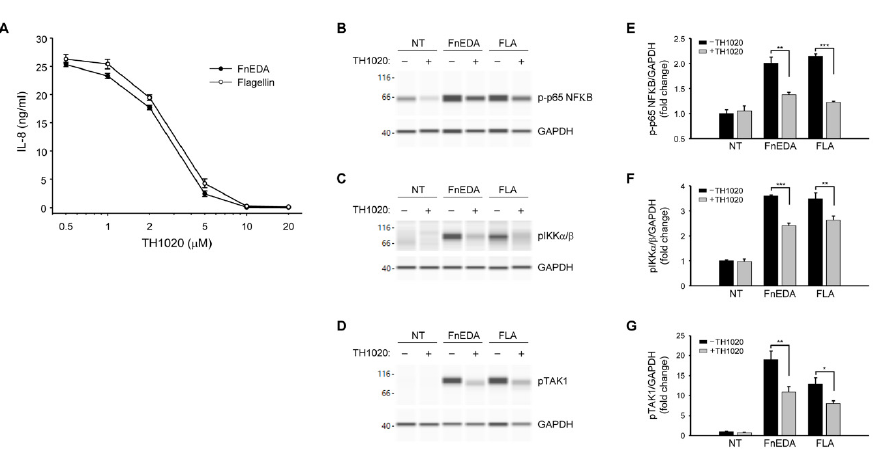
Figure 4. The TLR5 inhibitor, TH1020, blocks FnEDA-dependent IL-8 synthesis and NF κ B signaling in MDA-MB-468 breast cancer cells. ( A ) MDA-MB-468 breast cancer cells were incubated with in- creasing concentrations of the TLR5 inhibitor, TH1020, for 1 h prior to treatment with either FnEDA